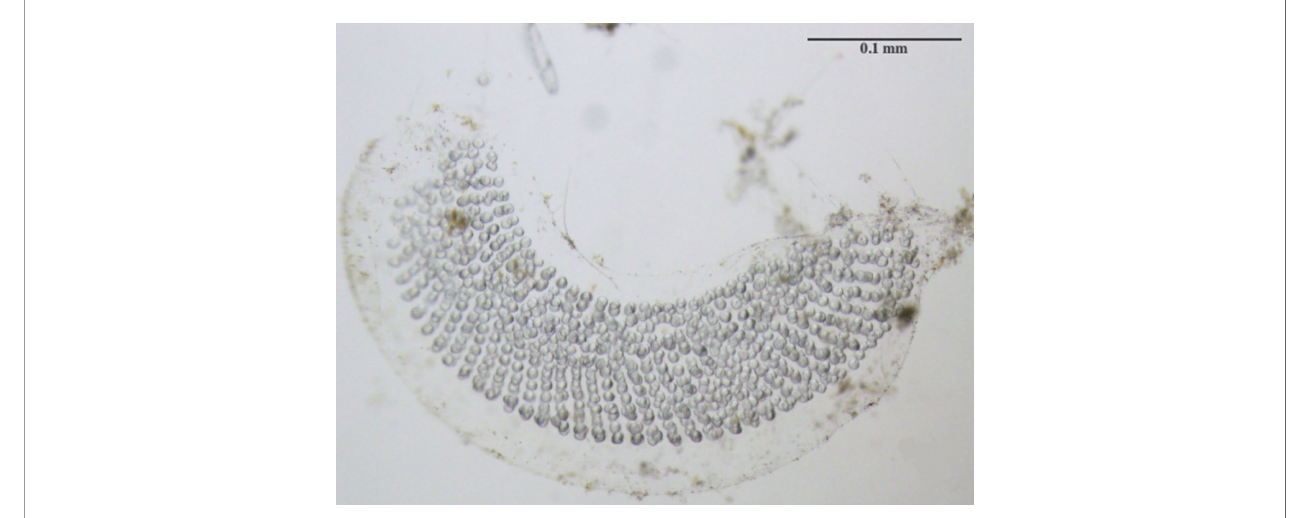
FIGURE 2 | Newly hatched egg mass consisting of hundreds of oval-shaped eggs arranged in a ribbon and embedded within an outer gelatinous matrix.